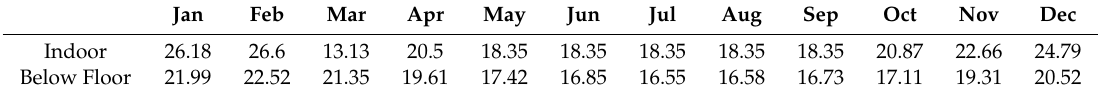
Table 2. Monthly averaged indoor (heated in winter) and beneath floor temperatures ( ◦ C).